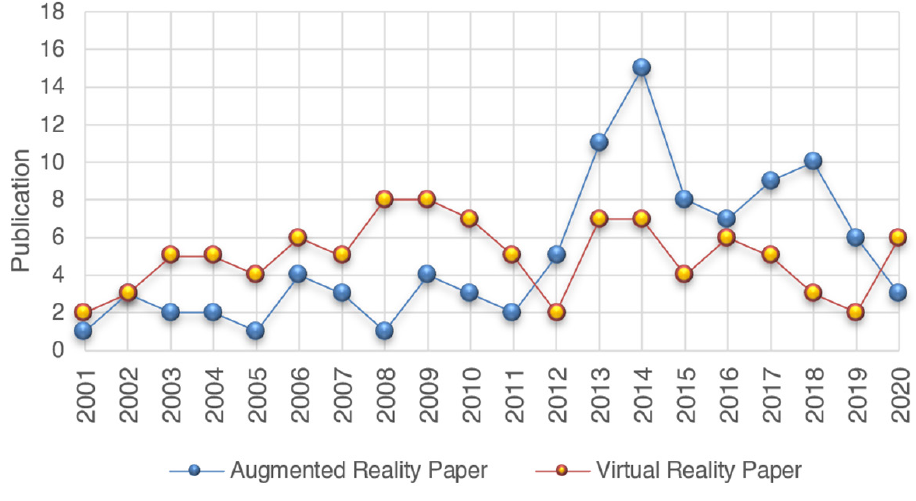
Fig. 6. Distribution of the top 100 cited